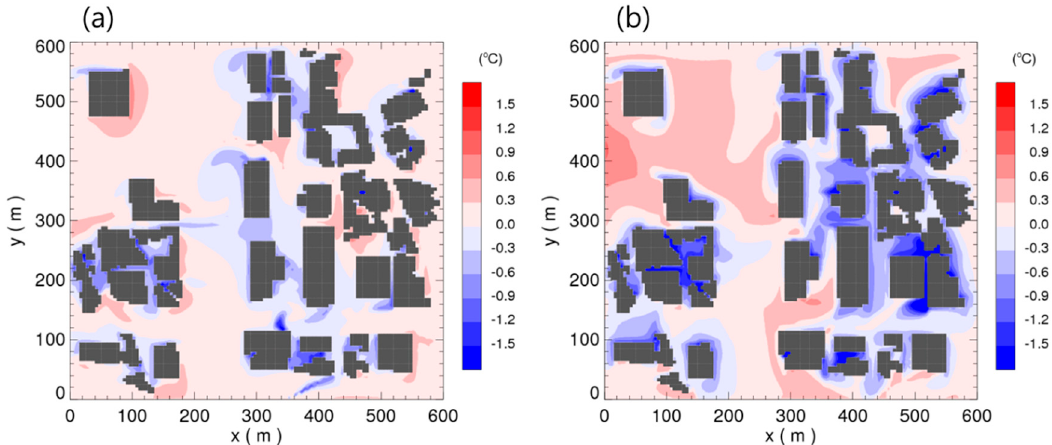
Figure 14. The spatial distributions of the pedestrian-level air temperature difference between the homogeneous and heterogeneous surface heating cases at ( a ) 10 LST and ( b ) 14 LST.